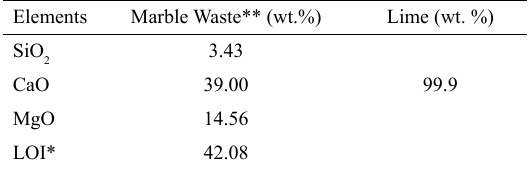
Table 2. Initial composition of cast iron used to desulphurization tests. Chemical composition (wt %) Mixtures